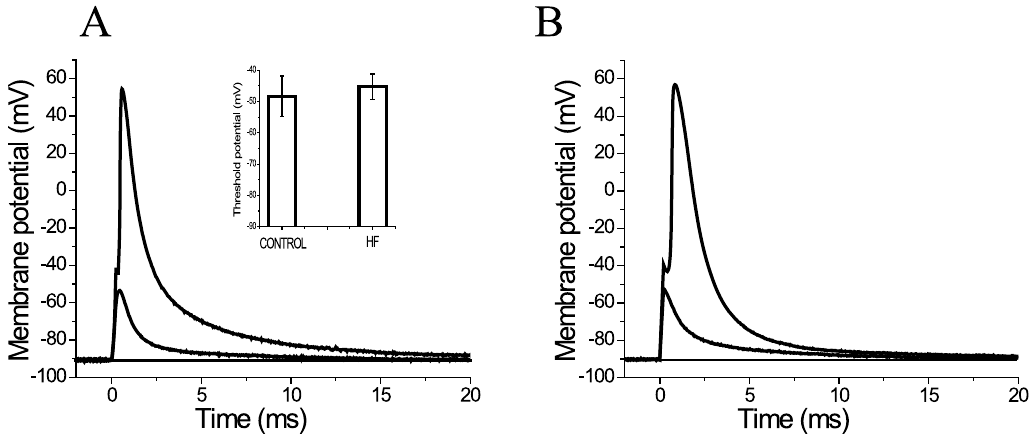
Figure 2. Fibers from healthy volunteers and HF patients have similar thresholds. Panels A and B show electrotonic responses (small depolarizations elicited by sub-threshold current pulses) and actions potentials (large autoregenerative depolarization elicited by suprathreshold current pulses) in a fiber from a healthy volunteer (A) and a HF patient (B). The inset in panel A shows the mean ( 6 SD) threshold potentials for a population of fibers from healthy volunteers (n=10 fibers) and HF patients (n=10 fibers).